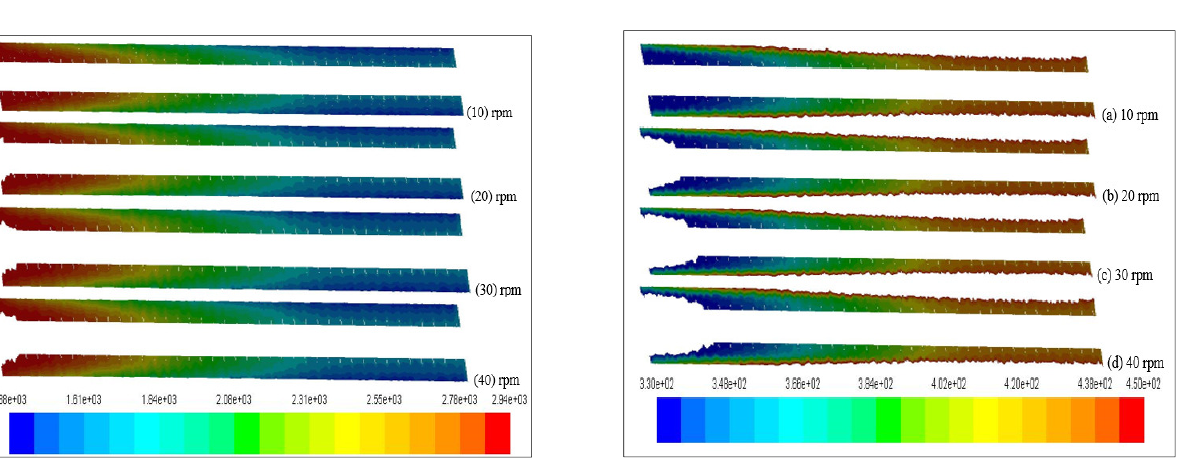
Fig. 5. Density Contour plane at 250 gm.